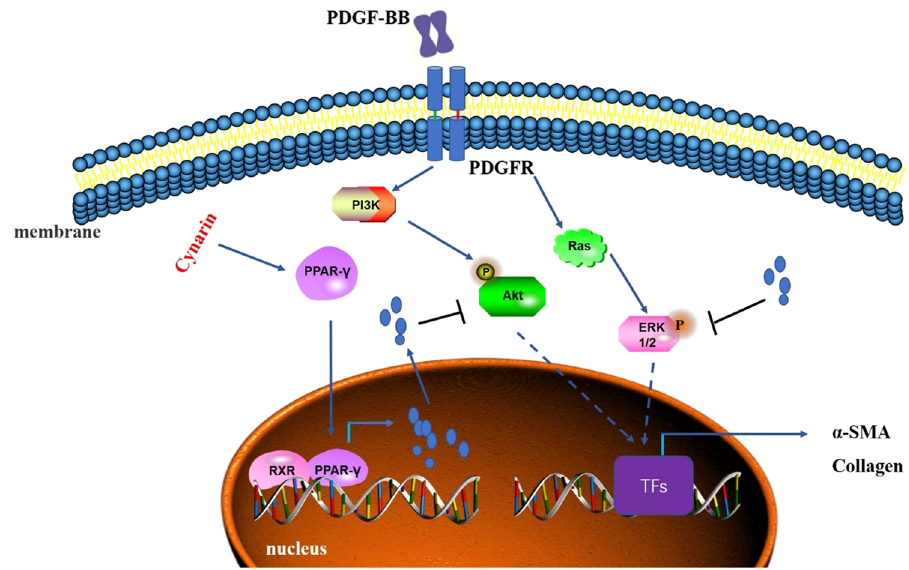
Figure 6: The schematic diagram of cynarin inhibiting PDGF - induced HSC activation via PPAR γ . Cynarin, as a novel PPAR γ partial agonist, activates PPAR γ to inhibit PDGF - BB - induced phosphorylation of ERK and AKT, thereby inhibiting HSC proliferation and